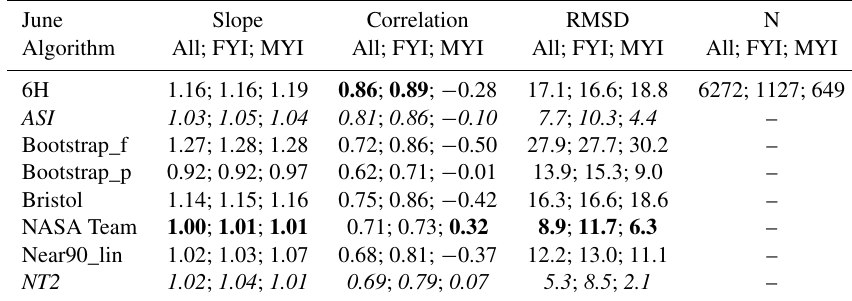
Figure 3. Time series of open-water and sea-ice fractions for all MODIS grid cells used in the present study for 1 June 2009 to 31 August 2009. Table 5. Statistical parameters of the comparison AMSR-E sea-ice concentration vs. MODIS sea-ice concentration (see Fig. 4) for June 2009. Each column gives the value for all grid cells with MODIS sea-ice concentration > 20%, the multiyear (MYI) ice grid cells, and the first-year ice (FYI) grid cells (see Sect. 2.4). Slopes closest to 1, highest correlations, and lowest RMSD values are noted in bold font. Values obtained for the ASI and NT2 algorithm are shown for completeness but are in italic